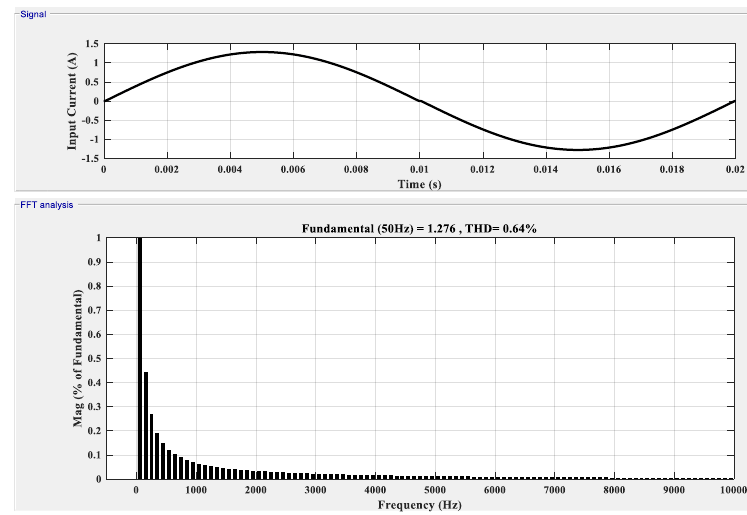
Figure 8. Power quality analysis of the input current. Electronics 2020 , 9 , 430